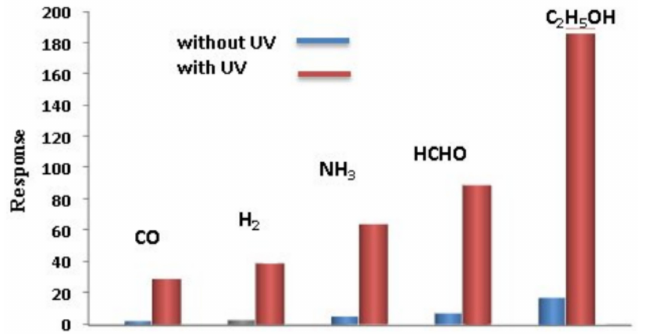
Figure 23. The response of TiO 2 nanofiber sensor under dark and UV illumination conditions to several gases with concentration of 75 ppm. Reprinted with permission from [141]. Copyright 2015